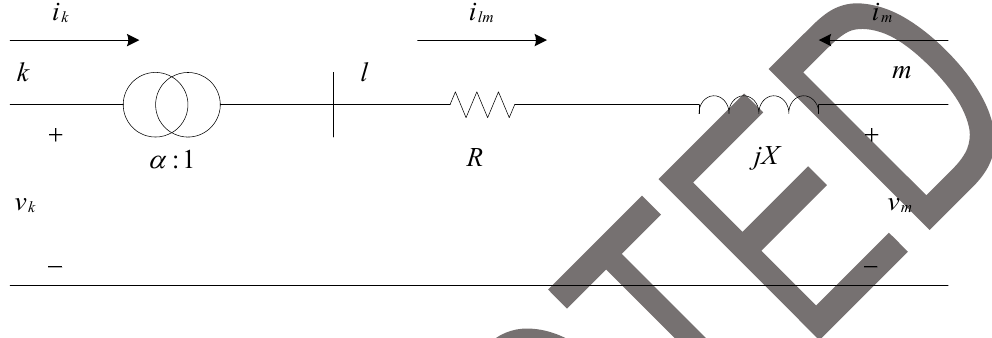
Figure 2. Equivalent circuit for a transformer.